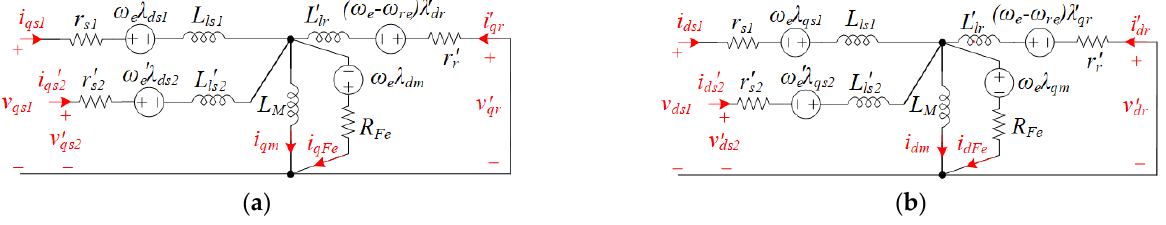
Figure 2. Equivalent circuits of the DWIM in the synchronous reference frame: ( a ) q-axis and ( b ) d-axis.